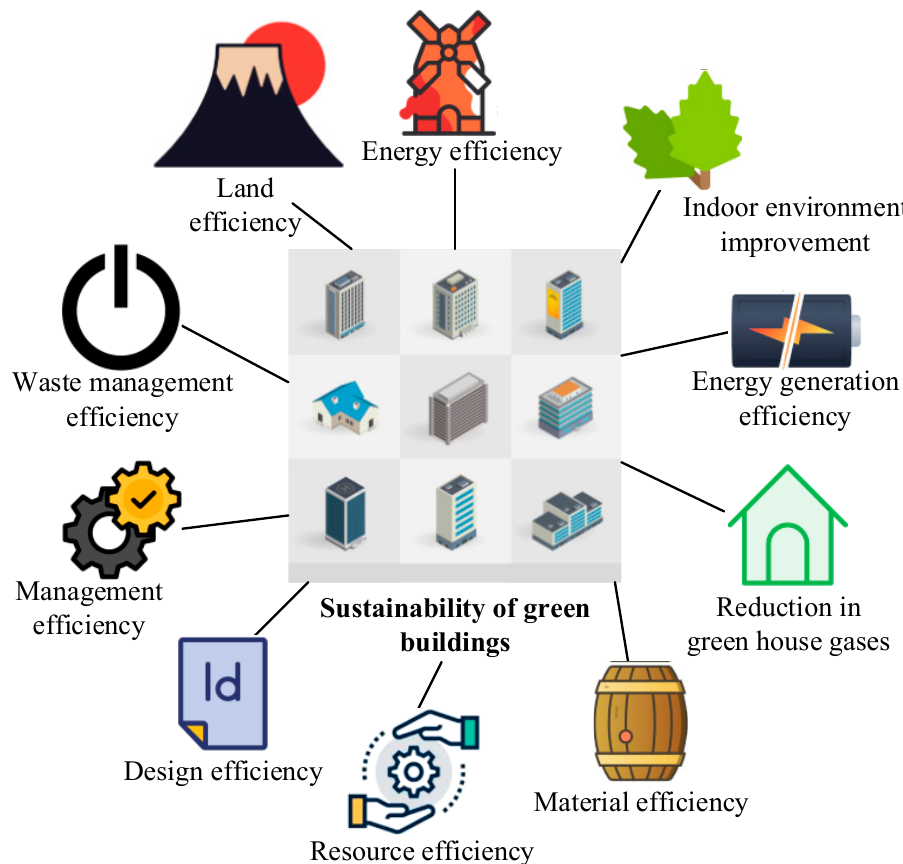
Figure 1. Sustainability dimensions of green buildings (Source: the authors).